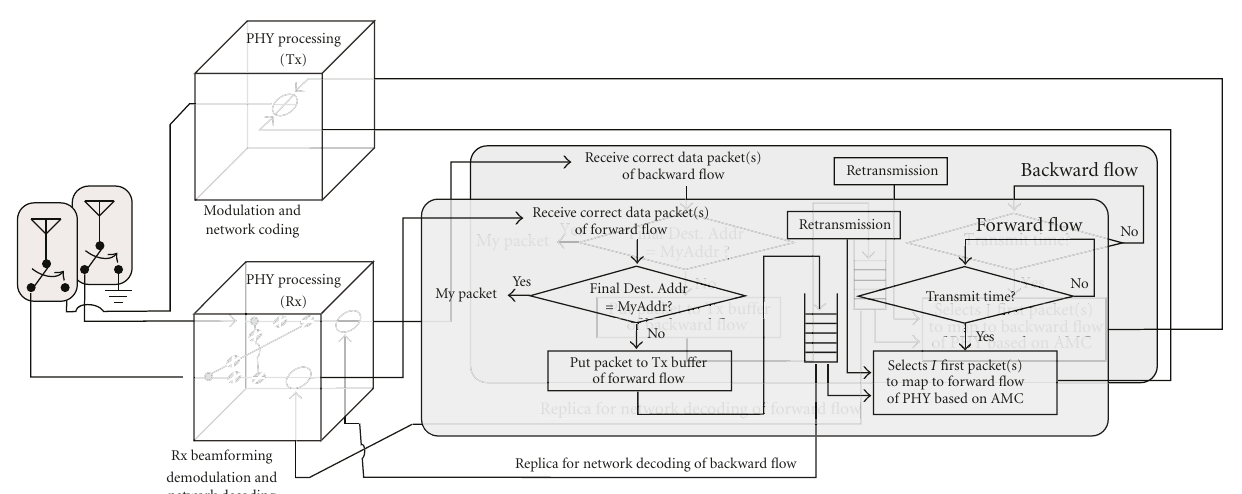
Figure 7: Packet relaying mechanism.